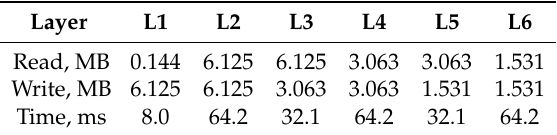
Table 6. Minimal requirements of on-board RAM for the first 6 convolutional layers’ implementation of VGG-13/16/19